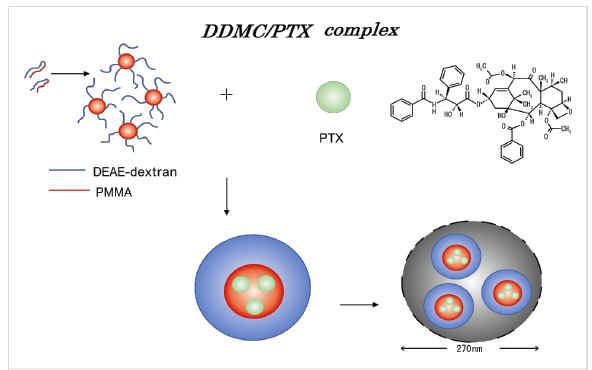
Figure 9: α , β -tubulin dimer orientates with the active site (i.e., pacli- taxel) of the DDMC/PTC complex. The DDMC/PTX complex (ca. 270 nm) will consists of more than 8.1·10 3 DDMC molecules and 6.7·10 6 paclitaxel molecules. Reprinted from